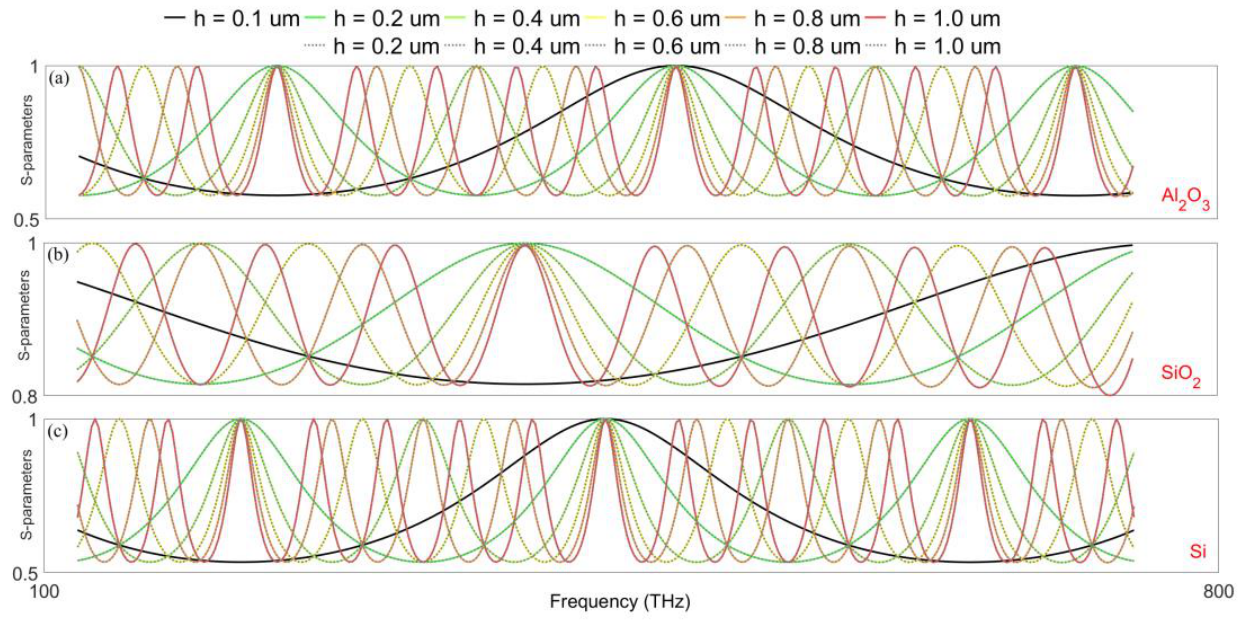
Figure 4. Cascade response when only transparent substrate is contained on 120 – 750 THz band. The black curve is the case with a thickness of 0.1 um, that is, the cascade benchmark. ( a ) Al 2 O 3 ; ( b ) SiO 2 ; ( c ) Si. In view of the single metal cascade in the mid infrared band, only gold is used as the research object here. Unlike transparent substrates, there are many free electrons in metals. When the response band is small (i.e., the frequency is higher), a small part of free electrons will participate in the coupling with photons, especially in the visible light band. It is worth noting that when the metal thickness gradually increases, the coupling strength will gradually weaken. Therefore, as shown in Figure 5, with the increase of the number of cascaded layers, the results of direct simulation and the results of cascade calculation are more